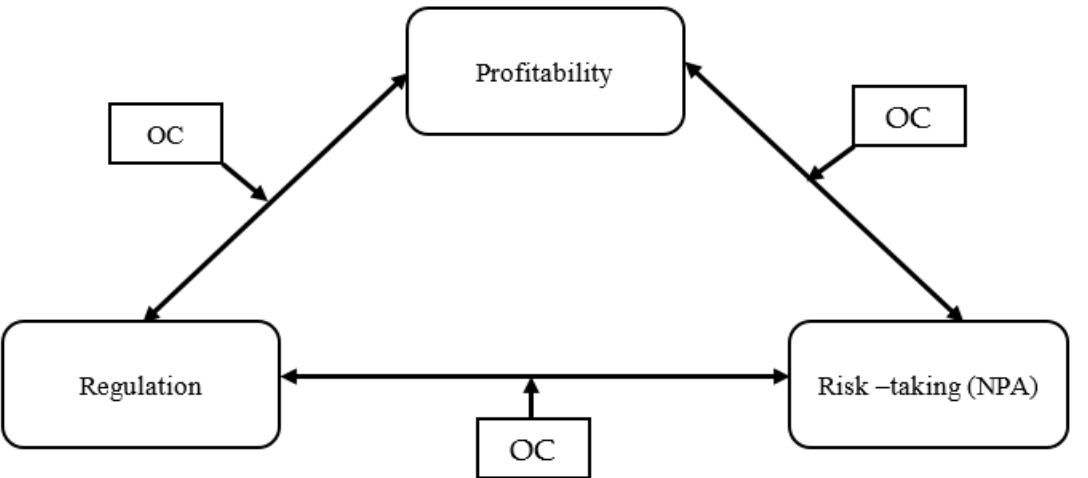
Figure 2. Conceptual model. OC is ownership concentration (includes promoters’, institutional investors’, and retail investors’ proportion of ownership in the banks).